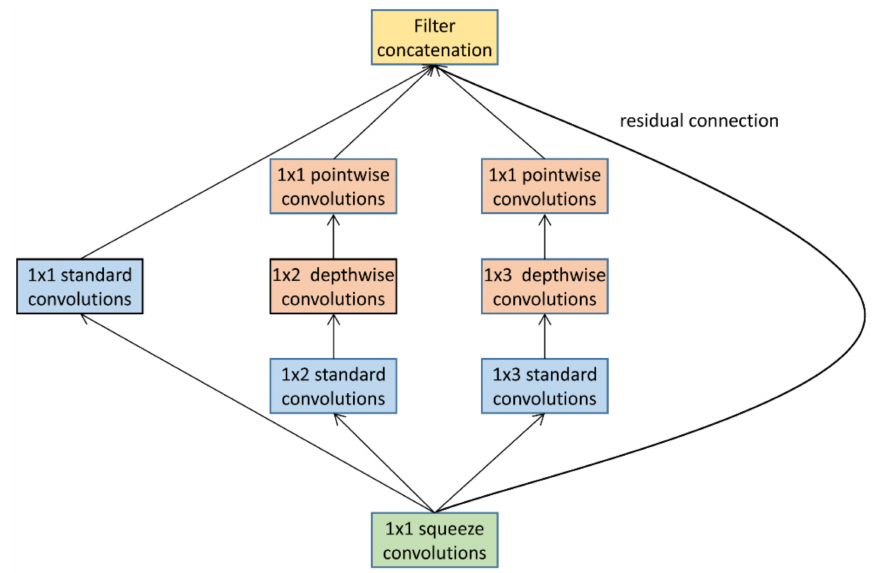
Figure 4. Lite module.